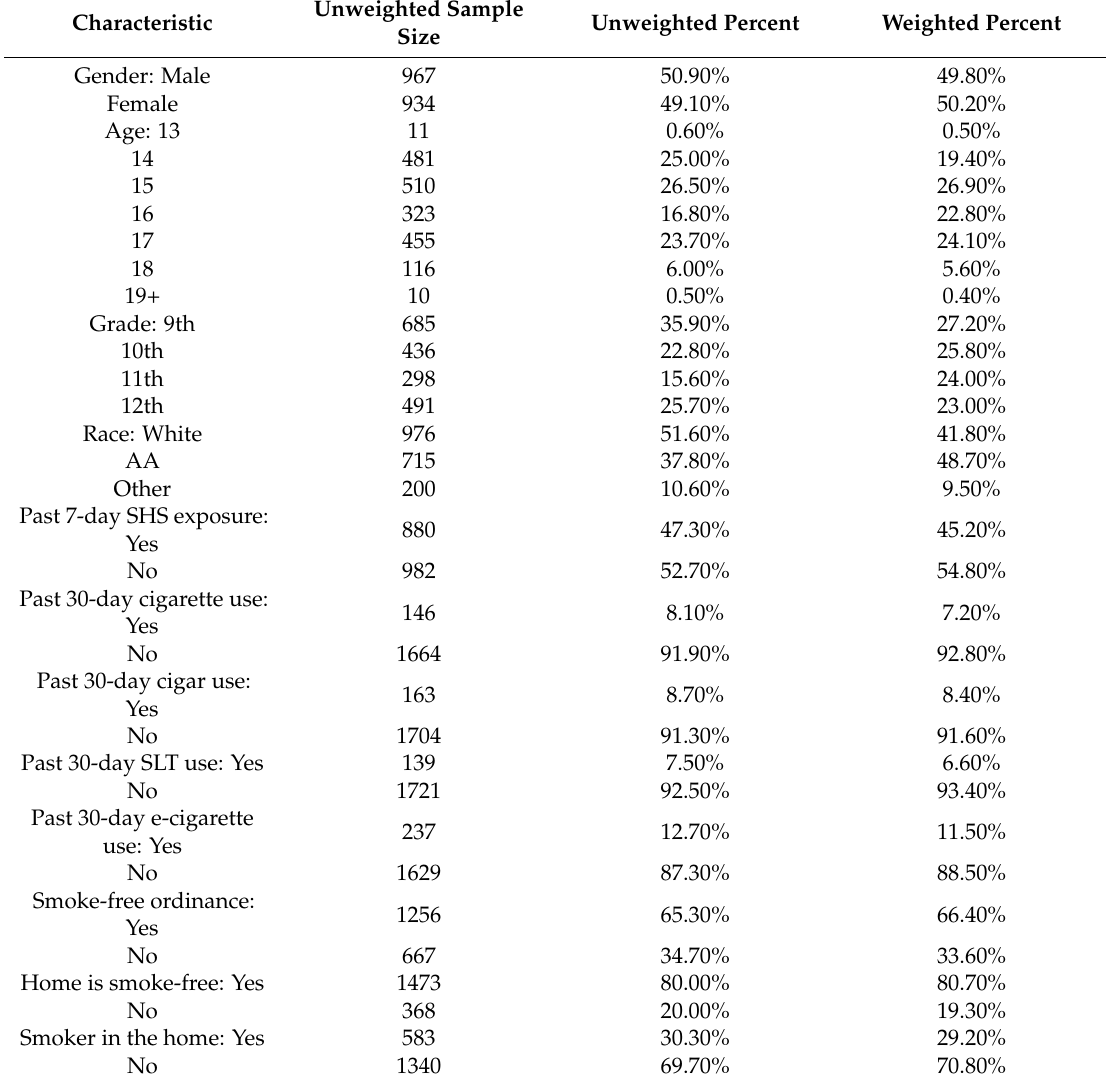
Table 1. Sample characteristics.